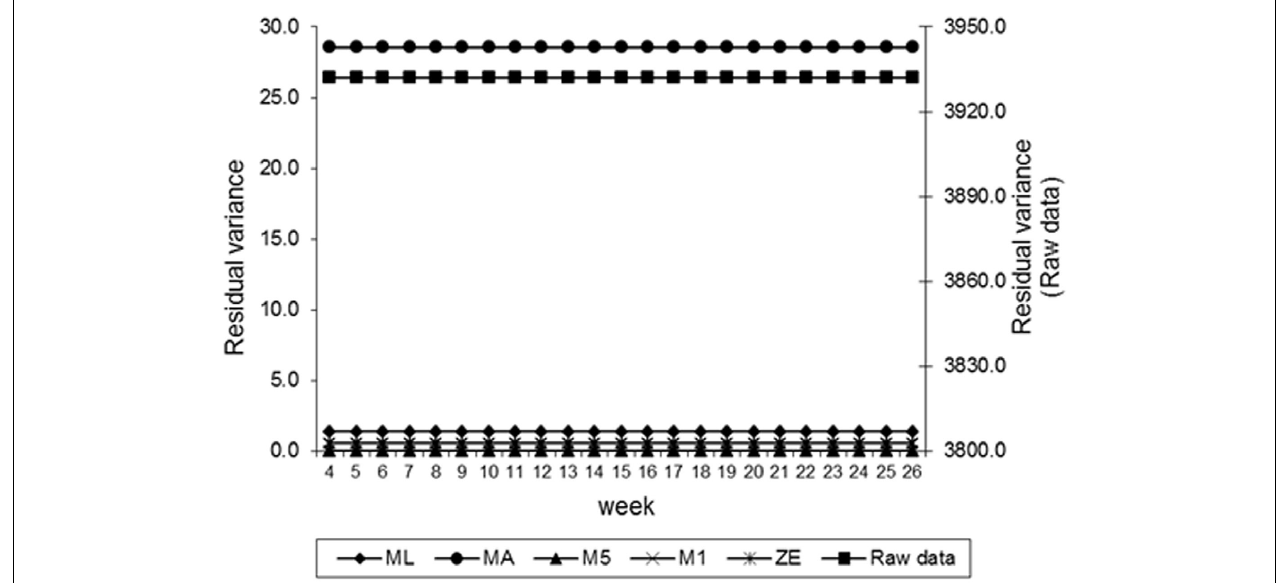
FIGURE 4 | Estimates of residual variance of fecal egg count (FEC) over time for different values of λ .